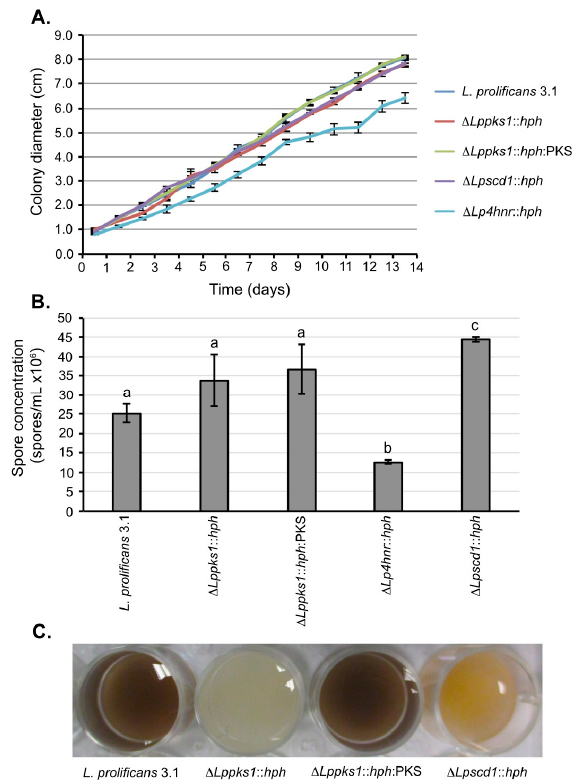
Figure 2. Phenotypic characterization of L. prolificans 3.1 and melanin mutants. ( A ) Colony diameters of fungi grown on OA for 14 days. By day 14, the mutant Δ Lp4hnr :: hph had significantly reduced growth when compared to the wild-type strain ( p < 0.05; Student’s t -test). All other mutants showed growth comparable to strain 3.1 over the 14 day period. Each point is the mean of 3 replicates ± standard error; ( B ) Quantification of spore concentrations from 14-day-old OA plate cultures. Spore concentration of the mutant Δ Lp4hnr :: hph was significantly reduced ( p < 0.05, analysis of variance (ANOVA)) when compared to strain 3.1 and the other mutants, whereas spore concentration was significantly increased in the mutant Δ Lpscd1 :: hph when compared to the other strains. There were no Each bar is the mean of 3 replicates ± standard error and bars with similar letters indicate that